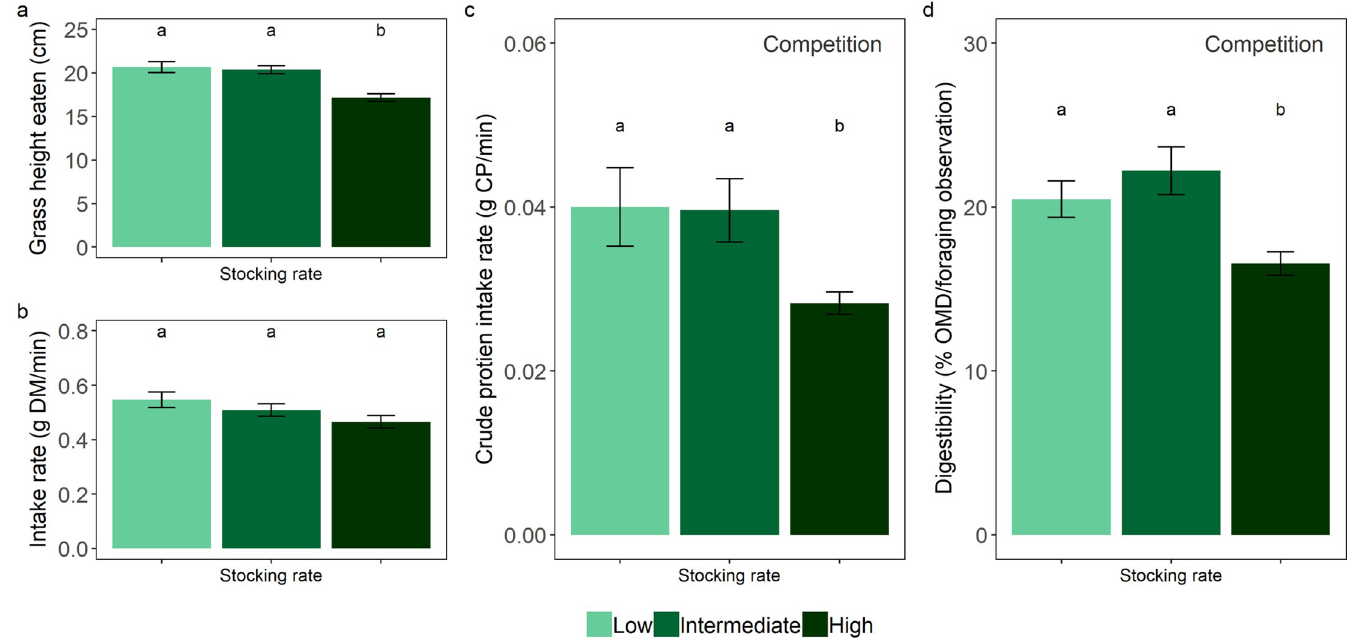
Fig 4. Dry season oribi antelope foraging metrics. Average (mean ± SE) for a) sward height eaten, b) intake rate, c) crude protein intake rate, and d) digestibility of consumed vegetation per foraging observation of oribi at low (1.7 ha per AU), intermediate (1.5 ha per AU) and high cattle stocking rates (0.95 ha per AU) during the dry season. The difference in crude protein intake rates and the digestibility of consumed vegetation by oribi between high cattle stocking rates and the lower cattle stocking rates is the degree to which cattle compete with oribi. Letters denote significant